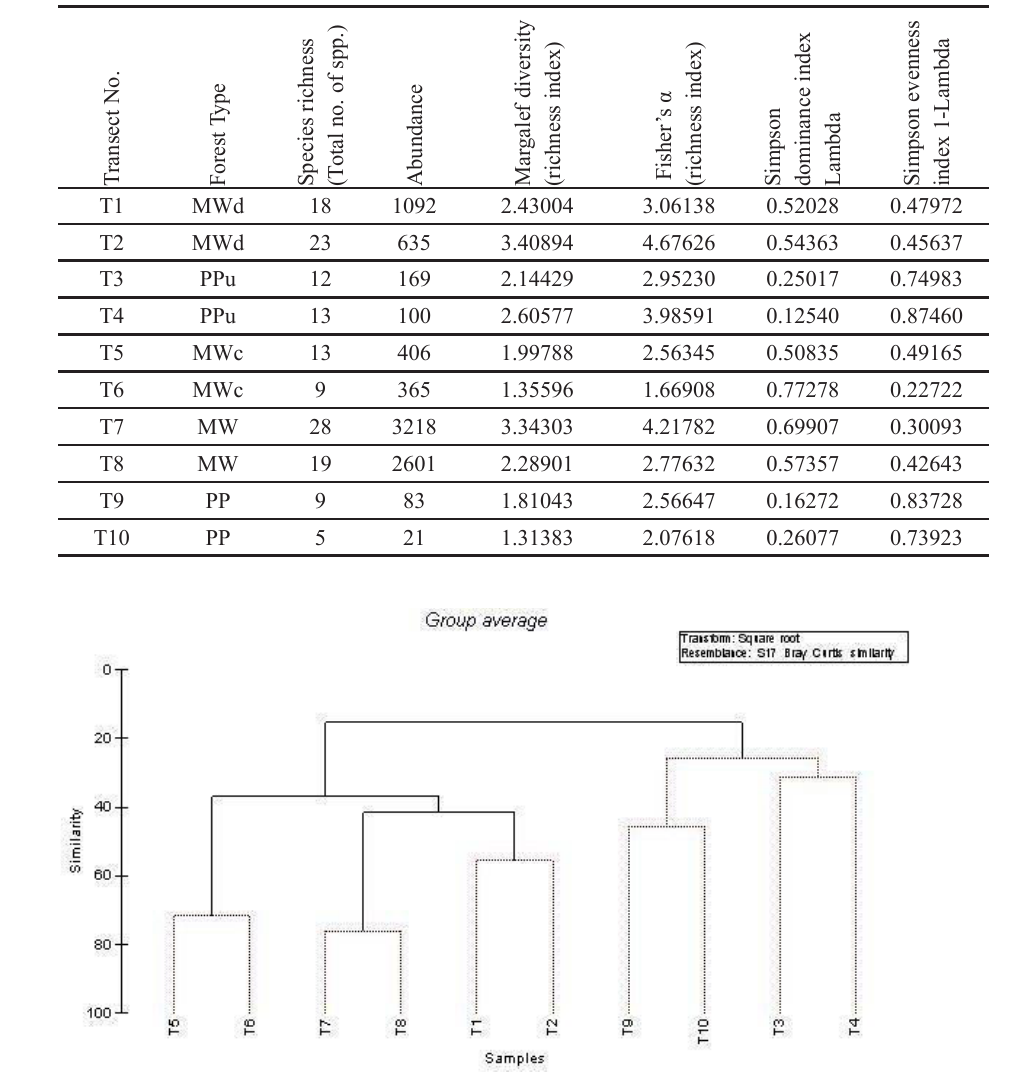
Figure 2: Dendrogram of ten 100 m transects (T1 & T2 – MWd; T3 & T4 – Ppu; T5 & T6 – MWc; T7 & T8 – MW; T9 & T10 – sampled for ants along an altitudinal gradient in the Hanthana Forest Reserve using group average clustering from Bray-Curtis similarities (samples connected by solid lines are significantly different while that of dotted lines are